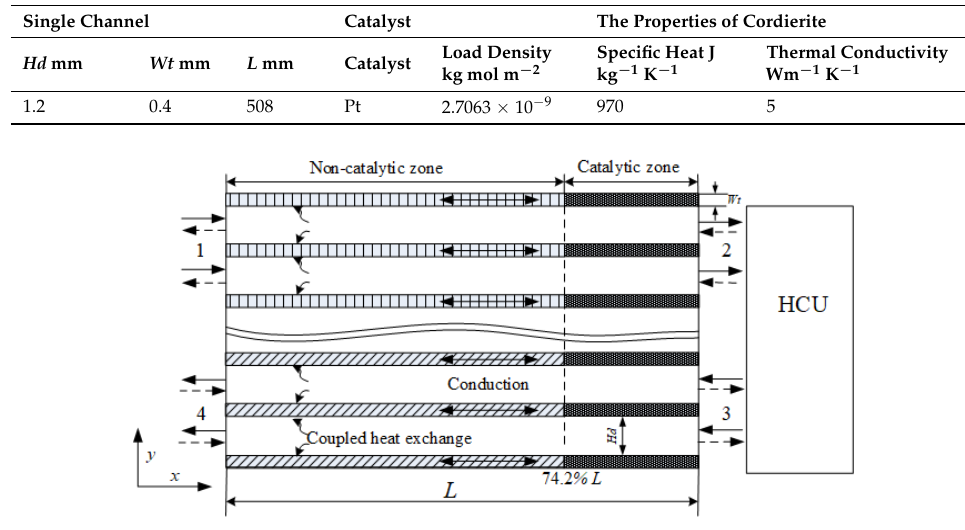
Figure 10. Schematic of the computational model.